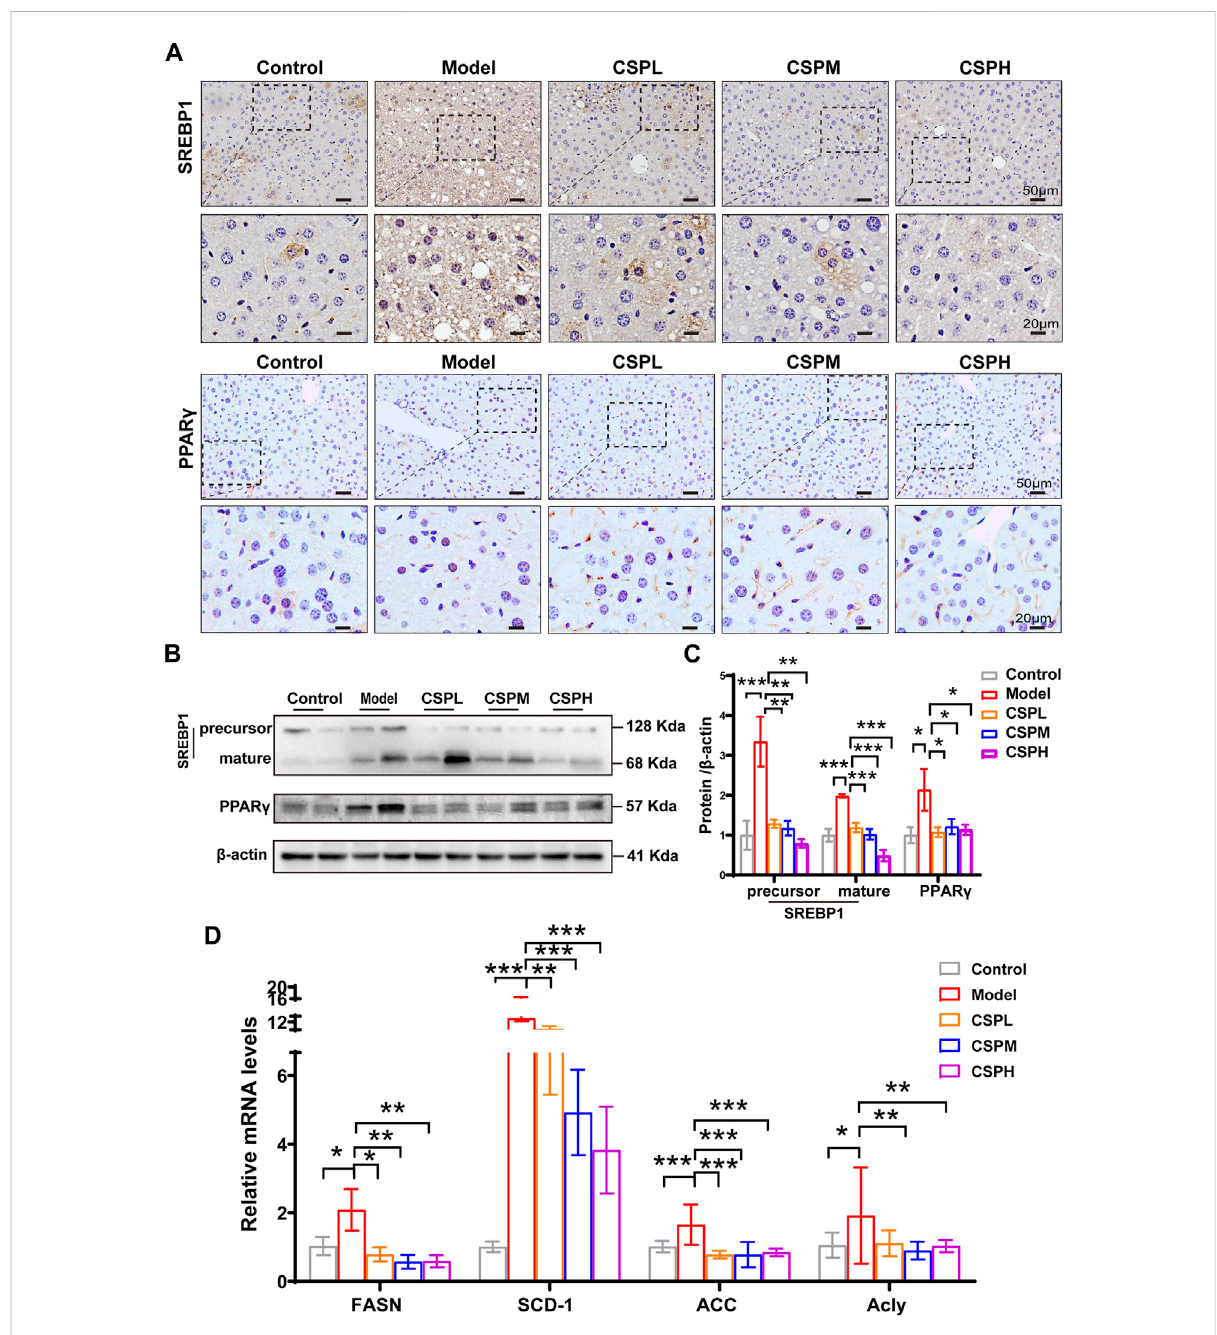
FIGURE 6 CSP treatment inhibited hepatic fatty acid synthesis in mice fed a HFHFD plus CIS. (A) Representative images of immunohistochemical staining ofSREBP-1andPPAR γ intheliversectionsofmiceat16weeks(scalebar:50 μ mand20 μ m). (B) TheproteinexpressionlevelsofprecursorSREBP-1, mature SREBP-1, and PPAR γ measured in the livers of mice at 16 weeks. (C) SCD-1, FASN, ACC and Acly expression levels in the liver from mice at 16 weeks measured by RT-PCR analyses. Data (C,D) are presented as the means ± s.d. * p < 0.05, ** p < 0.01, *** p < 0.001, n = 5-6 samples per